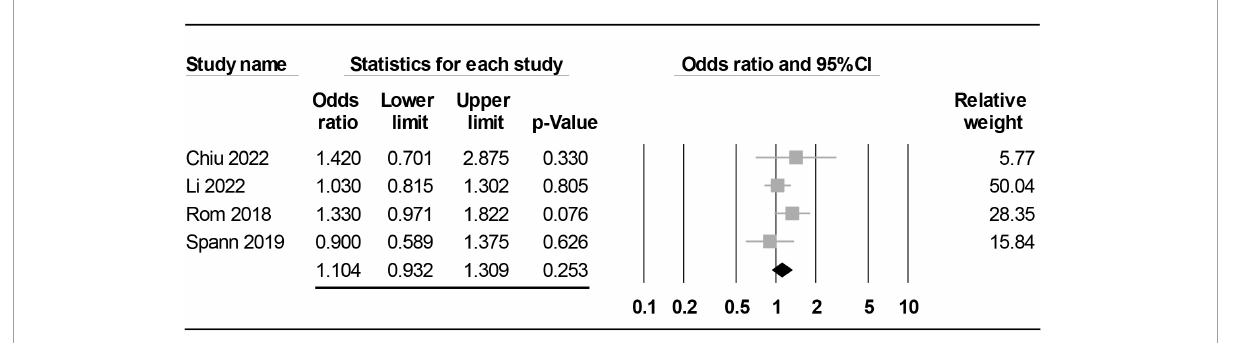
FIGURE4 Forest plot showing association of paternal rheumatoid arthritis (RA) with risk of offspring autism spectrum disorder (ASD). CI, confidence interval.